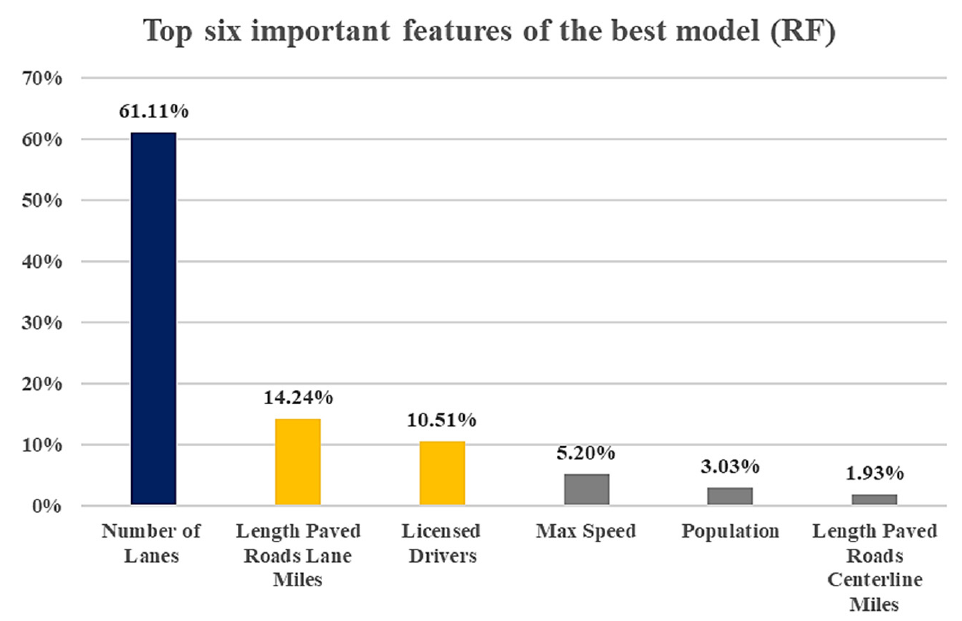
Figure 13. Top six important features of the best-performing models for total PVs.